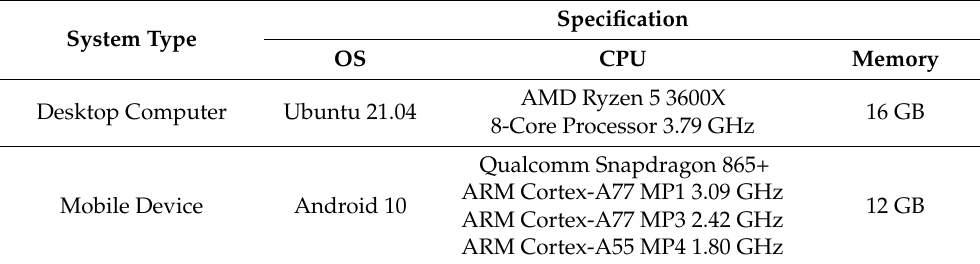
Table 1. Experiment Environment and Device